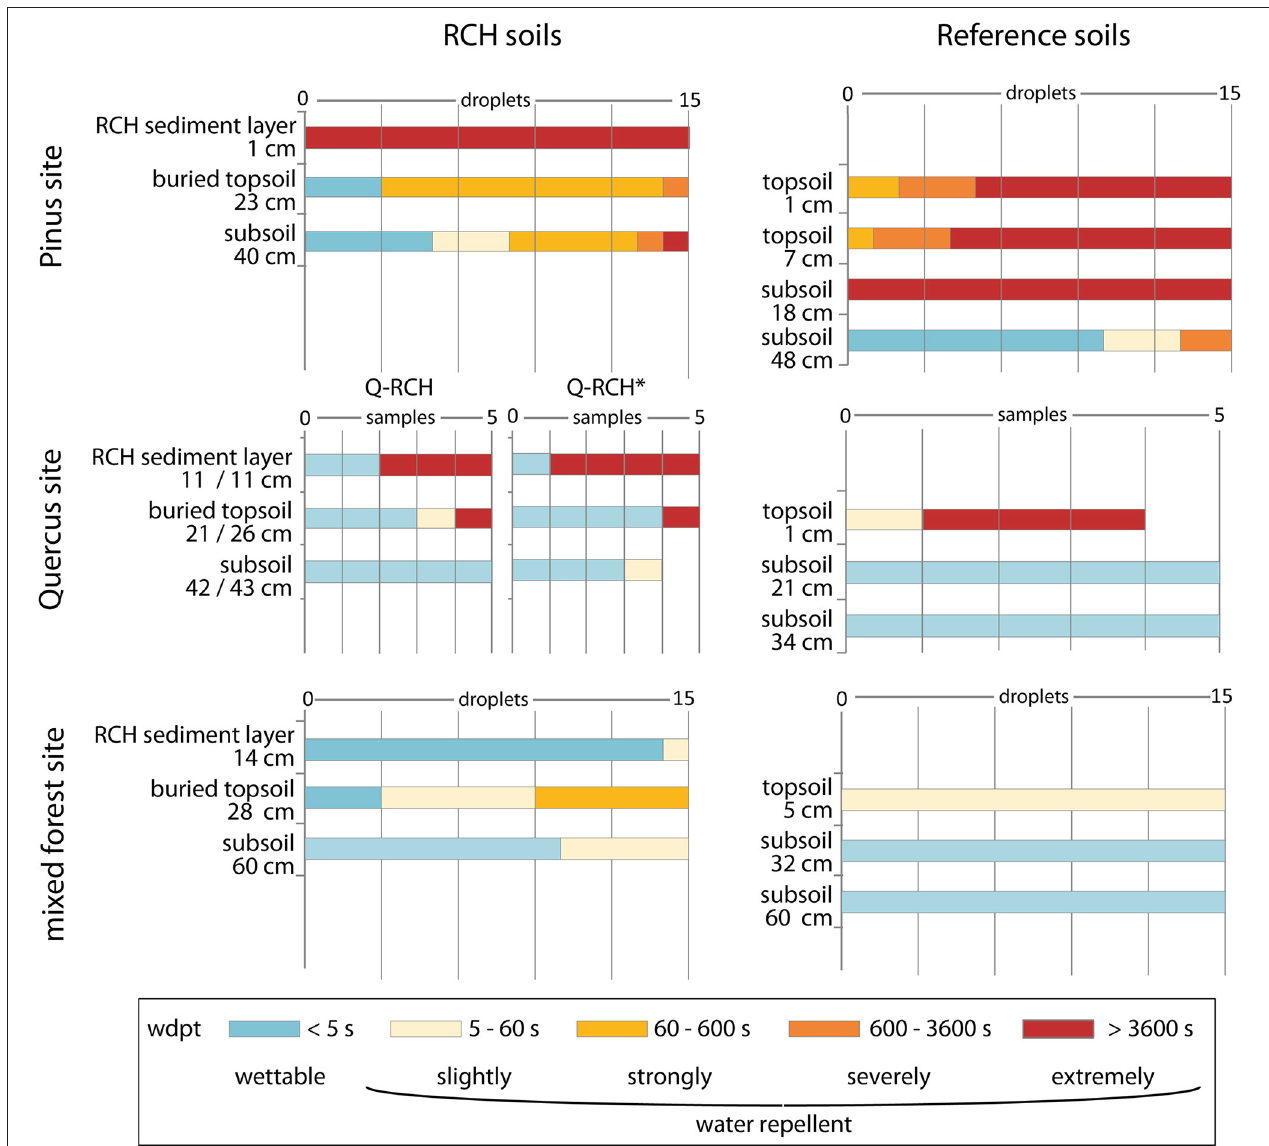
FIGURE 3 | Distribution of water drop penetration time categories for horizons of the charcoal hearth and reference soils of both sites. Wdpt classes were determined for 15 water droplets distributed over five undisturbed samples for each horizon, with individual droplet results given for sites P and M and the wdpt category determined from the mean infiltration time of three droplets on five samples for site